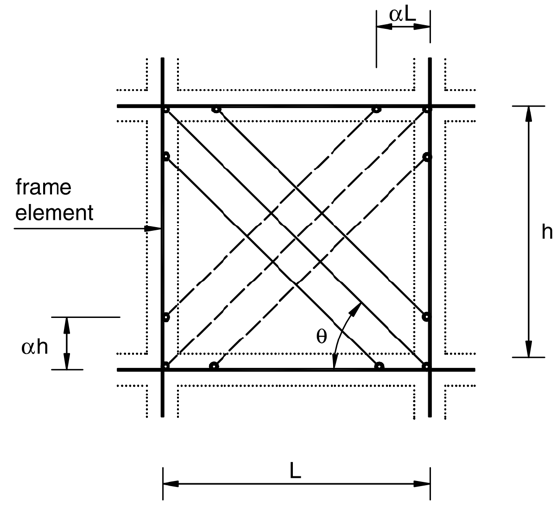
Figure 4. Triple-strut model, node-to-node (adapted from Ref. [255]). Paulay and Priestley (1992) concluded that using a large strut width would result in a stiffer structure and consequently in a higher seismic response [240]. With that concern they proposed a modified strut width (see Table